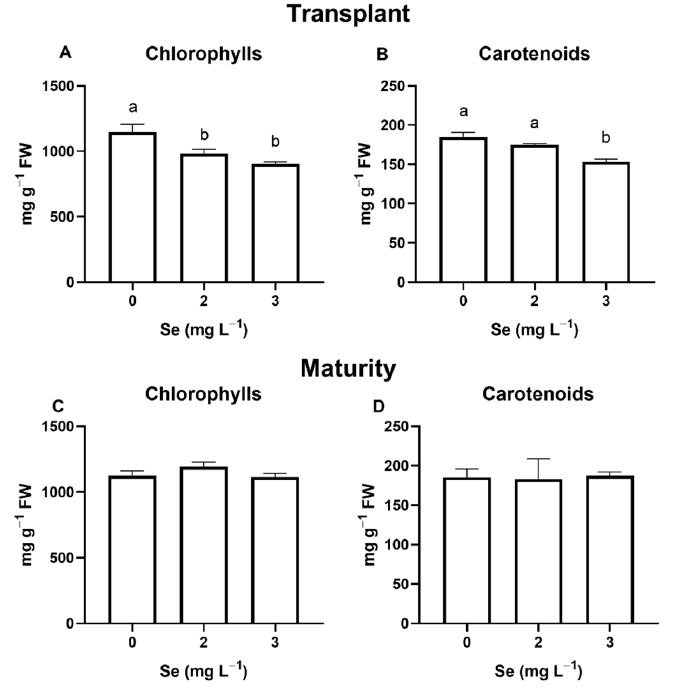
Figure 8. Total chlorophyll and carotenoid contents, measured at transplant ( A , B ) and maturity ( C , D ), in leaves of basil plants treated with different concentrations of Se at pre-transplanting. In subfigures ( A , B ), means ( n = 3) flanked by different letter are statistically different for p = 0.05 after Tukey’s test.